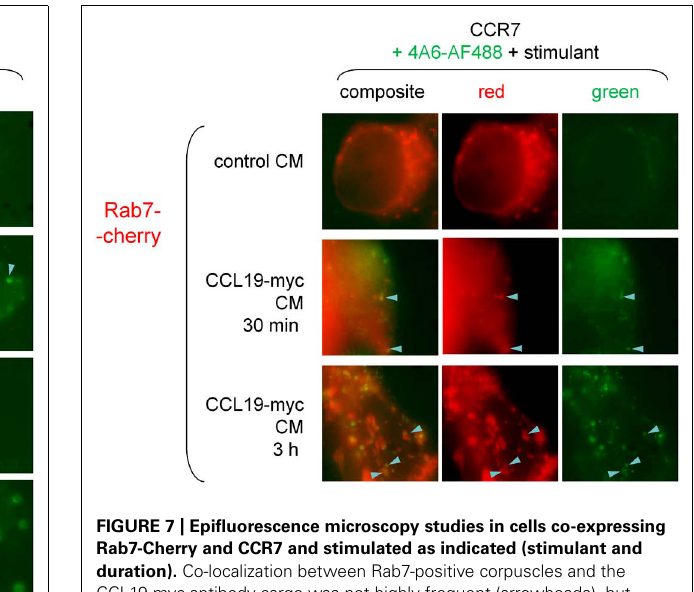
FIGURE 7 | Epifluorescence microscopy studies in cells co-expressing Rab7-Cherry and CCR7 and stimulated as indicated (stimulant and duration). Co-localization between Rab7-positive corpuscles and the CCL19-myc-antibody cargo was not highly frequent (arrowheads), but increased in frequency as a function of incubation duration (see text for numerical analysis).